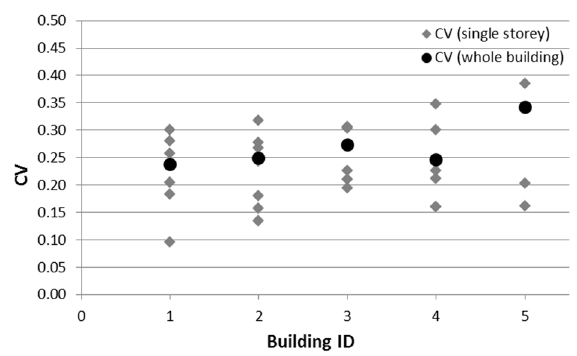
Figure 10. CV values computed in the single storeys and in the whole building.